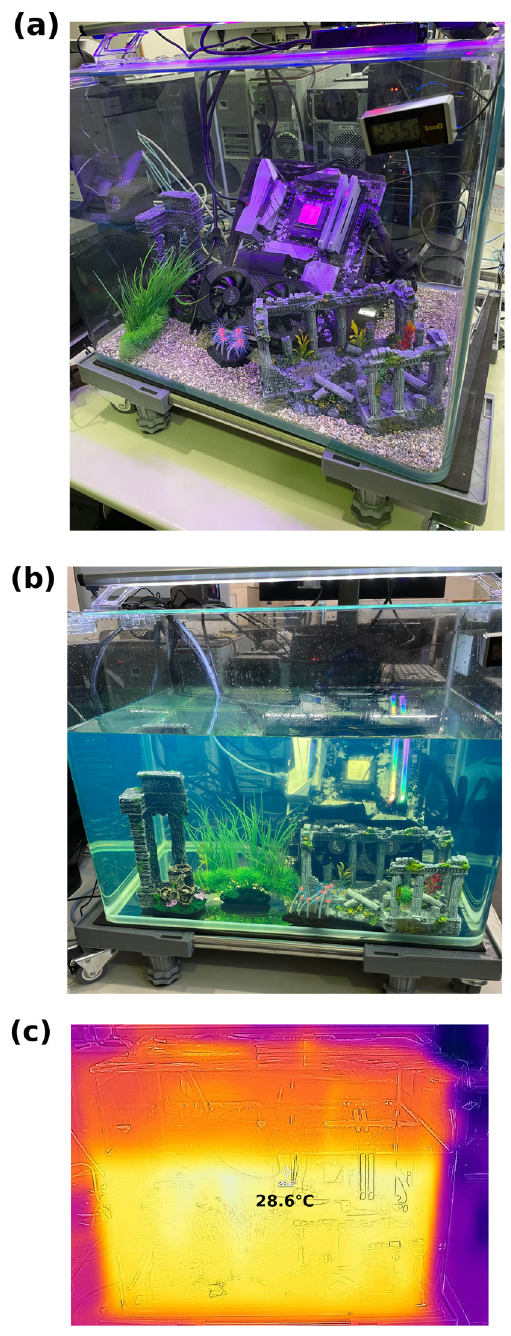
Fig 1. The constructed computer server (a) without the presence of the transformer oil and (b) fully submerged in the transformer oil. (c) Thermal imaging of the submerged computer server under operation.